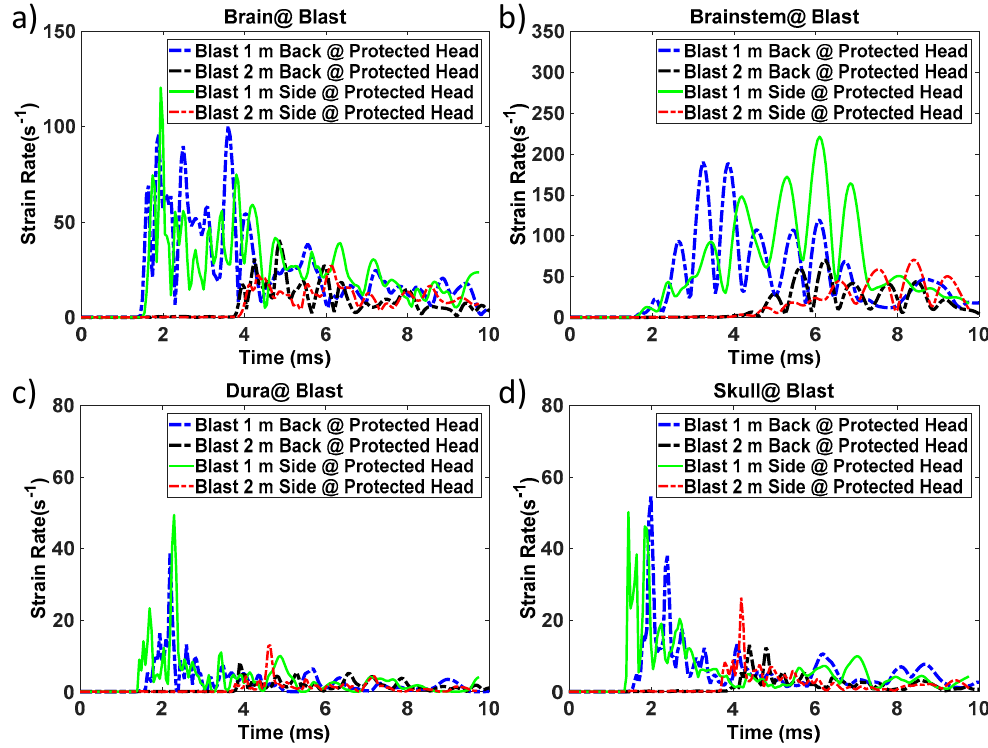
Figure 8. History of highest calculated strain rate during four blast scenarios for: ( a ) brain, ( b ) brainstem, ( c ) dura, and ( d ) skull. Table 6. The estimated maximum linear acceleration of skull, and strain rate of the brain, brainstem, skull, and dura at different impact scenarios.